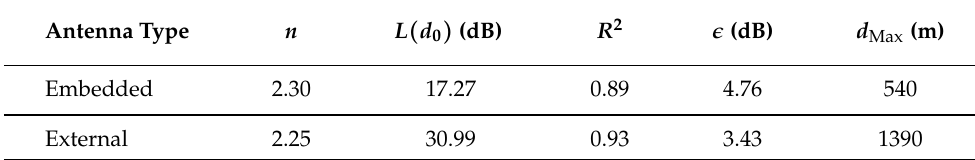
Figure 5. IQRF path loss model for the Non-Line-of-Sight link. Table 6. Path Loss Regression Coefficients and Statistical Results for the Line-of-Sight Scenario.